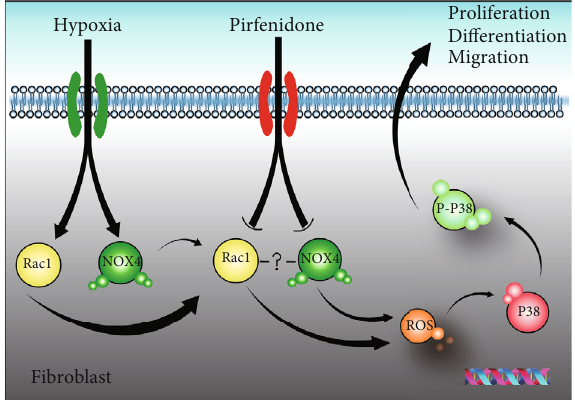
Figure 7: The role of PFD on HPAAFs in hypoxia. In the human pulmonary artery adventitial fi broblasts, PFD reduced hypoxia- induced cell proliferation, migration, and di ff erentiation through the NOX4/ROS/P38 signaling pathway. Meanwhile, there was no direct cross e ff ect between NOX4 and Rac1. PFD: pirfenidone; ROS: reactive oxygen